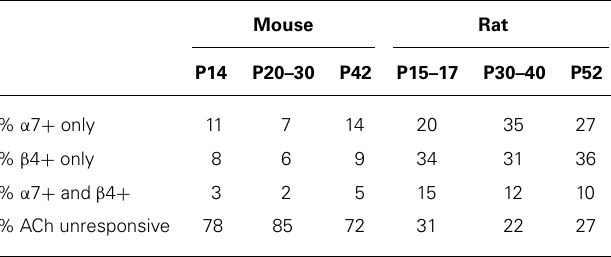
Table 2 | Percentages of the total population of mouse and rat DRG neurons that exhibited functional expression of different nAChR